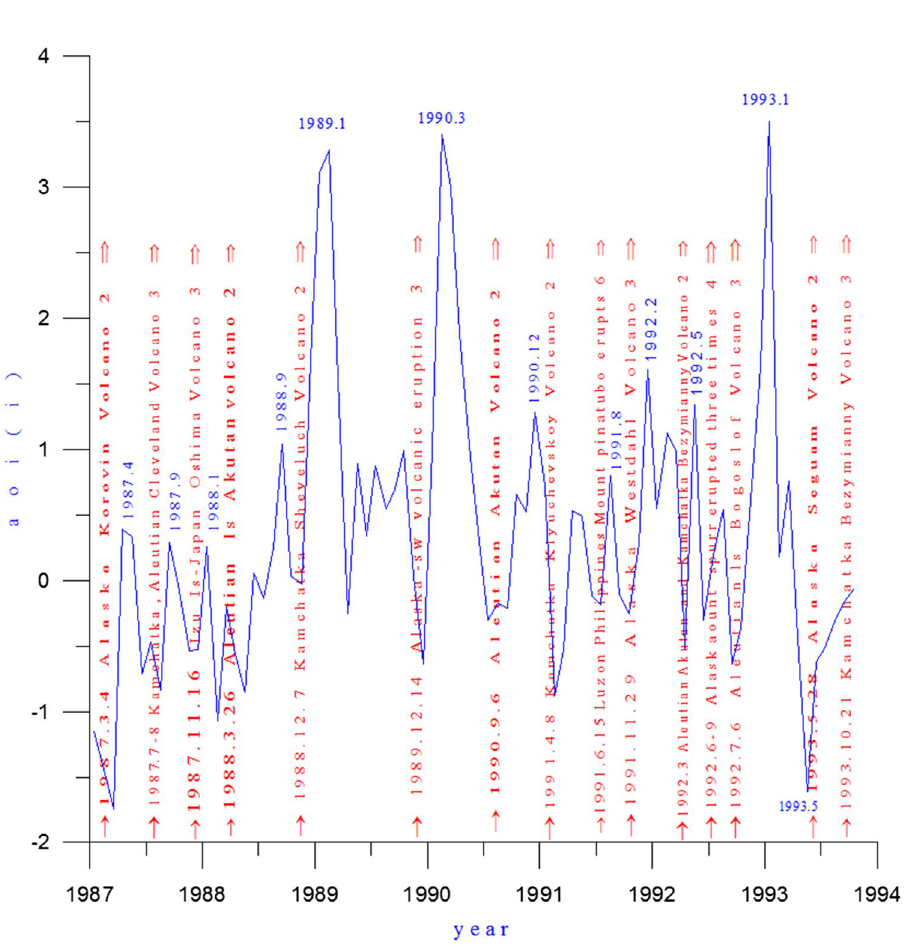
Figure 1. AOI (blue line) and volcanic activity (red arrows) from 1987 to